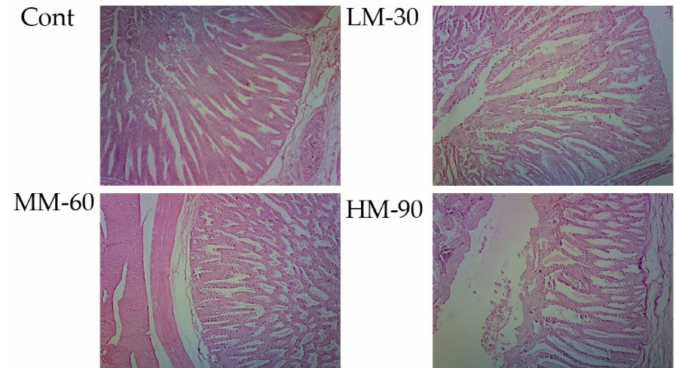
Figure 5. Photomicrographs showing the effect of β -mannanase supplementation on jejunum mor- phology in broilers fed low energy diets. Cont (ME 3100 kcal/kg): without β -mannanase; LM-30 (ME − 30 kcal/kg), MM-60 (ME − 60 kcal/kg), and HM-90 (ME − 90 kcal/kg) were supplemented with 200, 400, and 600 mg/kg β -mannanase, respectively. H&E staining, the scale is 10 ×